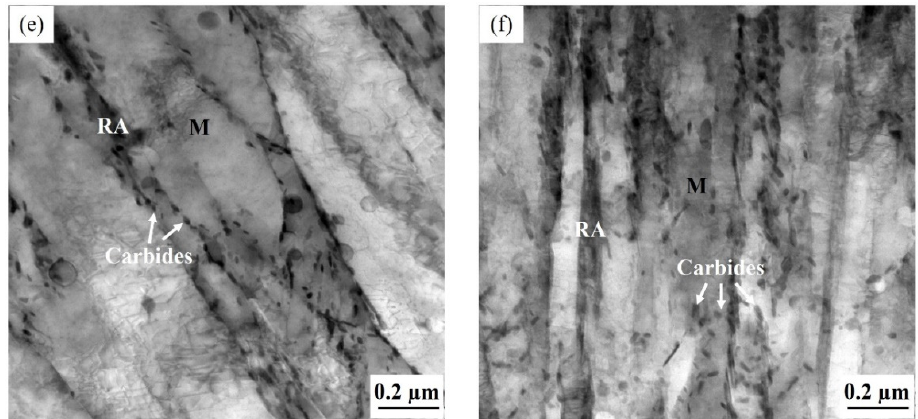
Figure 2. TEM micrographs of the specimens: ( a , c ) for the bright and dark field image of 1.54Si-60s; ( b , d ) for the bright and dark field image of 1.26Al-60s; ( e , f ) for the 1.54Si-1800s and 1.26Al-1800s, respectively.